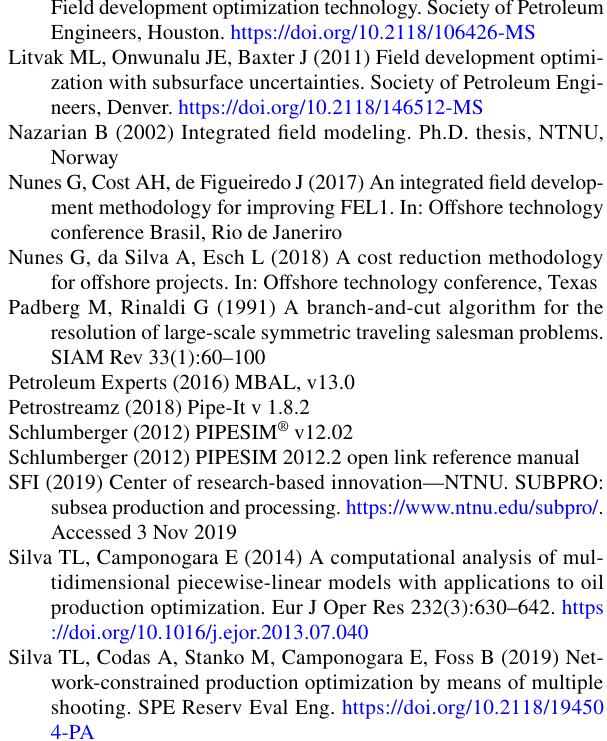
Fig. 25 Optimum oil production profile and oil production potential for strategy Tie-back with MPB +